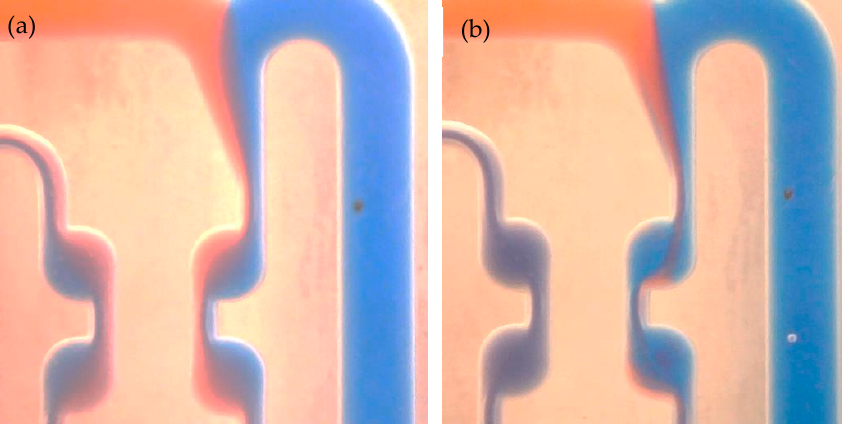
Figure 11. Mixing in a chicanes microreactor at different volume flow rates: ( a ) 0.1 mL/min; ( b ) 5 mL/min.